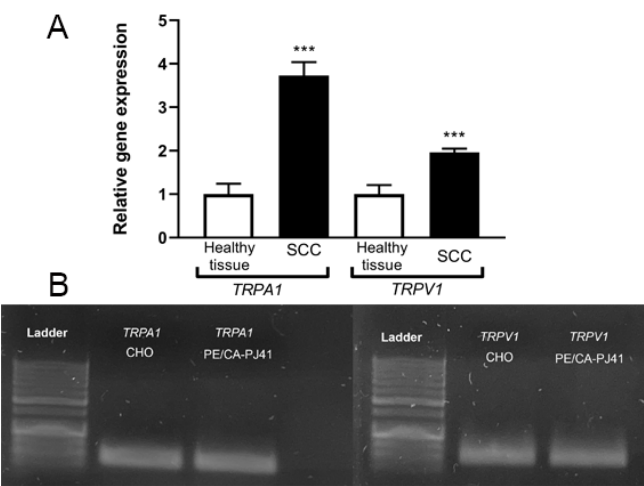
Figure 2. Relative gene expression ratios of Transient Receptor Potential Ankyrin 1 ( TRPA1 ) and Vanilloid 1 ( TRPV1 ) receptors normalized to the Importin 8 (IPO8) reference gene in the healthy control oral mucosa (n = 10), compared to oral squamous cell carcinoma (OSCC; n = 15). Columns represent the mean + SEM, *** p < 0.001, Mann–Whitney U test; ( A ). Expression of TRPA1 and TRPV1 mRNA in the PE/CA-PJ41 cell line and TRPA1 and TRPV1 expressing CHO cells (positive controls) (n = 4/group; ( B )).